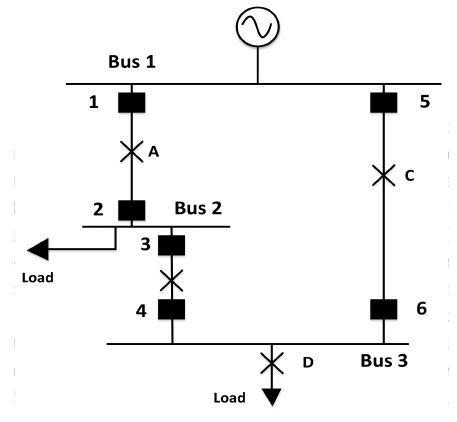
Figure 13. A multi-loop distribution